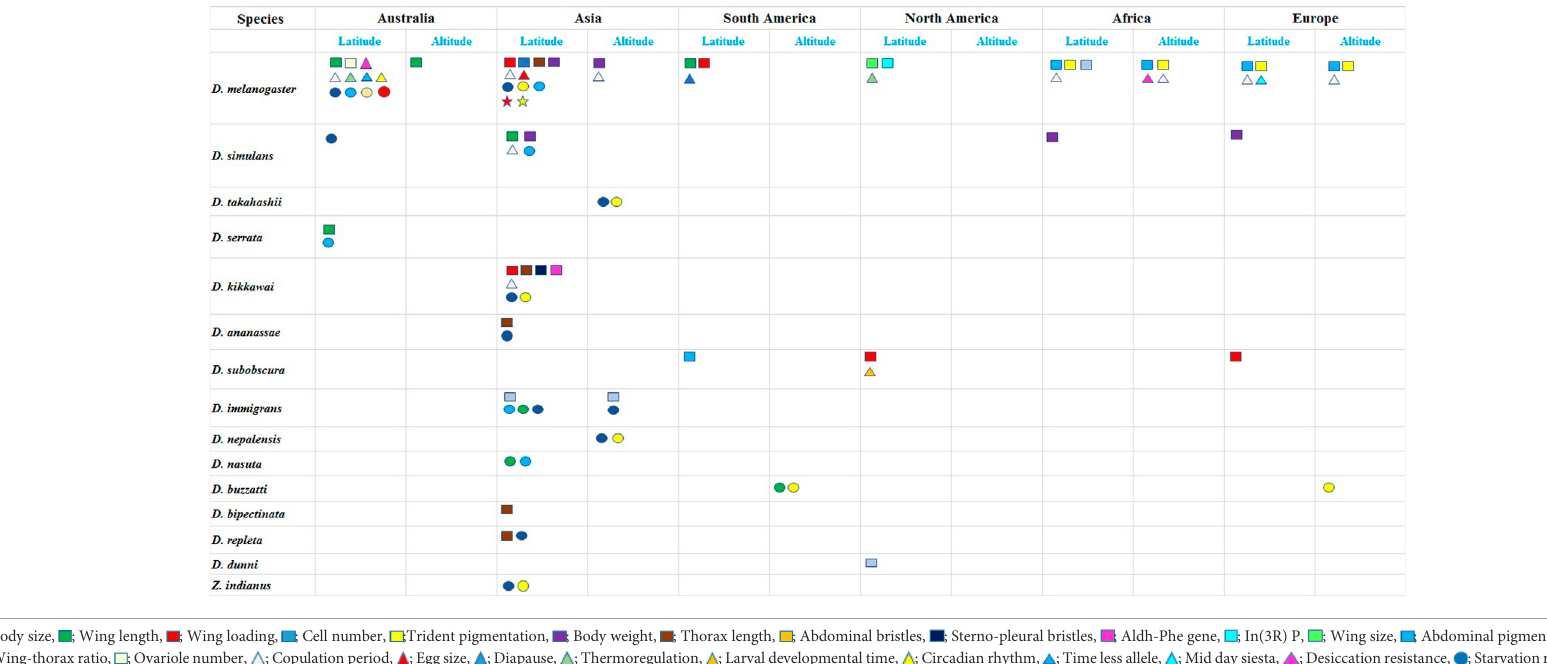
TABLE1Latitudinalandaltitudinalclinesin Drosophila specieshavebeenpresentedfromsixcontinents.Eachtraitexhibitingaclineisrepresentedbyacodedcoloursymbol(refertoboxbelow).Clinesare broadlycategorized as:morphological,reproduction, development andbehaviour, stress resistance andenergy reserves.There isconsiderable parallelism as wellasvariation for thesametraitacross continents. Traits for clines are codes with different symbols and